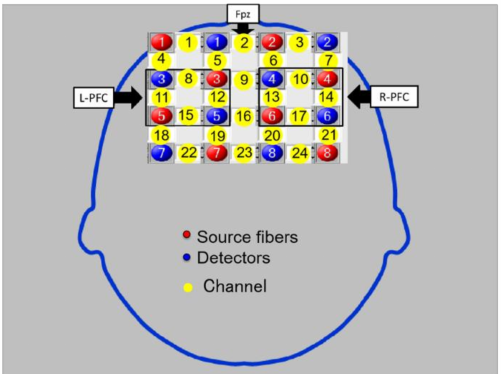
Figure 2. The red dot represents the source fibers, the blue dot shows the detectors, and the yellow dot shows 24 channels. Fpz corresponds to channel 2; L-PFC corresponds to channels 8, 11, 12, and 15; and R-PFC corresponds to channels 10, 13, 14, and 17. L-PFC: left prefrontal cortex, R-PFC: right prefrontal